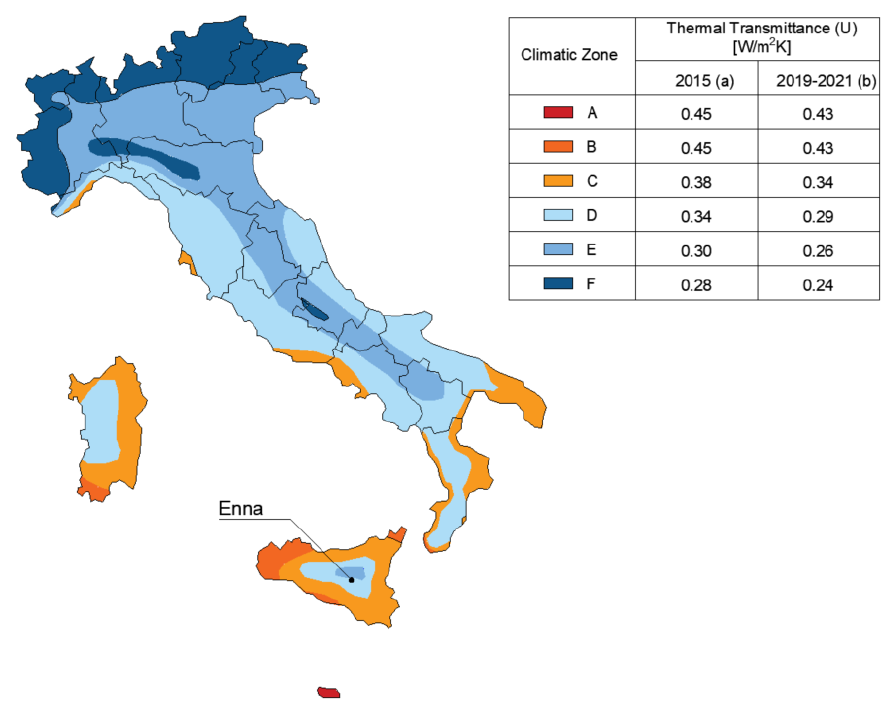
Figure 2. Italian climatic zones and related thermal-transmittance limits for external walls. Limits in the “a” column entered into enforcement on 1 July 2015, whilst those in the “b” column entered into enforcement on 1 January 2019, for public-destination buildings, and 1 January 2021 for all other buildings, as reported above and based upon intended use [37].